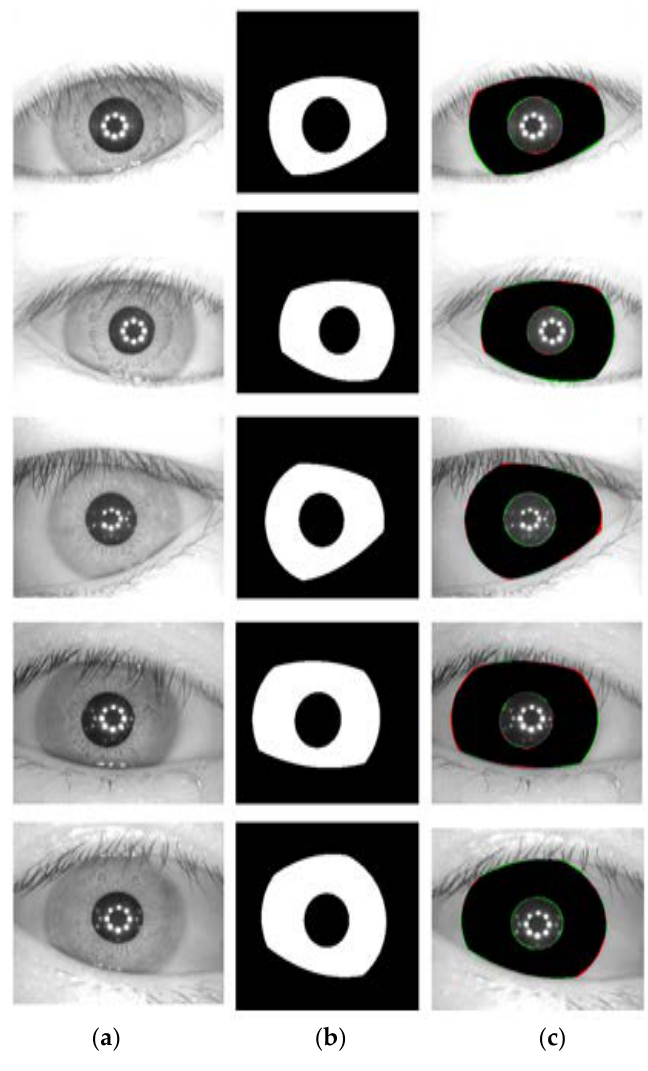
Figure 15. Examples of correct segmentation results in CASIA v4.0 interval database by the proposed method. ( a ) Original image. ( b ) Ground-truth image. ( c ) Segmentation result by IrisDenseNet (The false positive and negative errors are presented as green and red, respectively. The true positive case is presented as black).